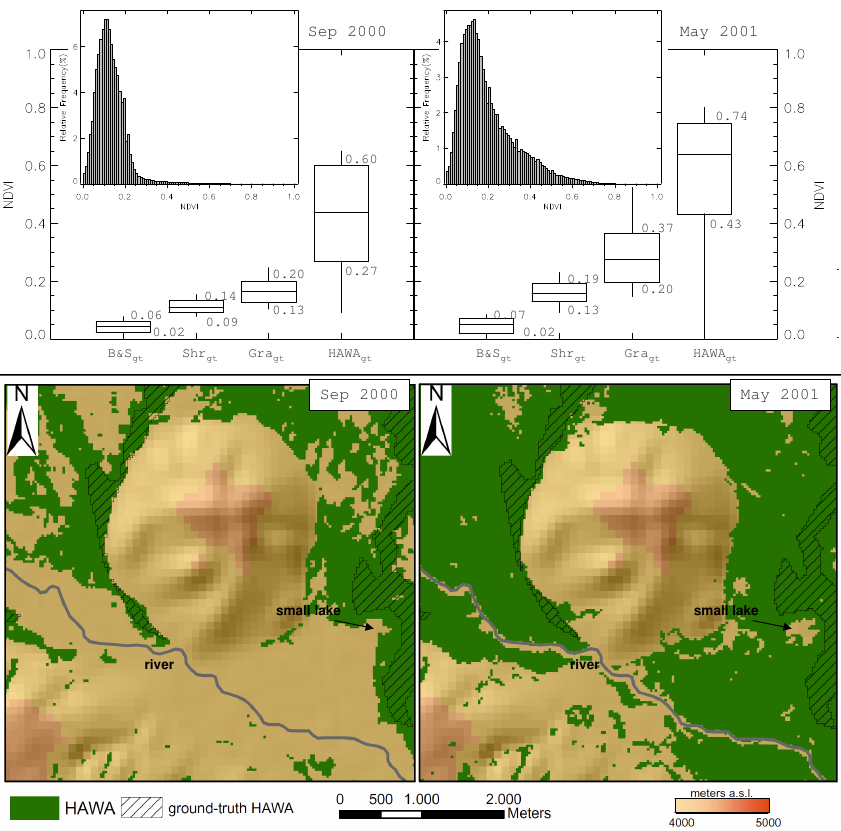
Fig. 6. Box plots (upper part) of five hundred stratified randomly sampled grid values for each ground-truth dataset of September 2000 and May 2001. Box range is set to P5% and P95% together with median and maximum/minimum grid values for each land cover class. Lower part of Fig. 5 depicts HAWA mapped in September 2000 and May 2001 applying thresholds as depicted in the respective box plots (upper